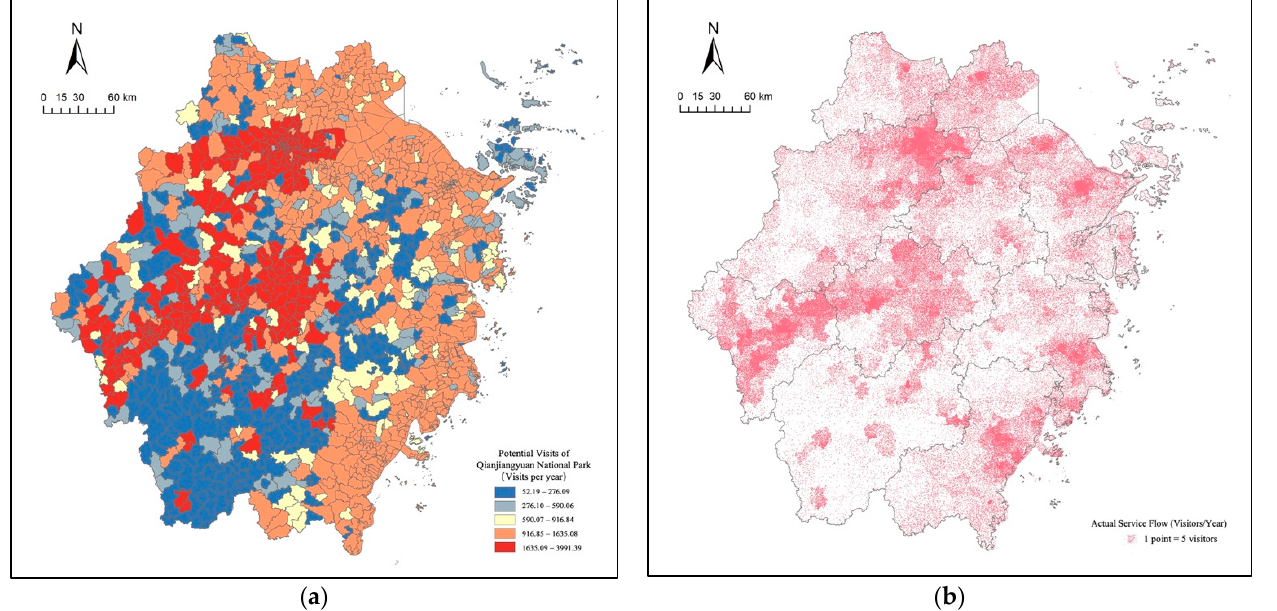
Figure 3. ( a ) The potential visits to Qianjiangyuan National Park in Zhejiang Province; ( b ) The actual service flow of recreational ecosystem services of Qianjiangyuan National Park.